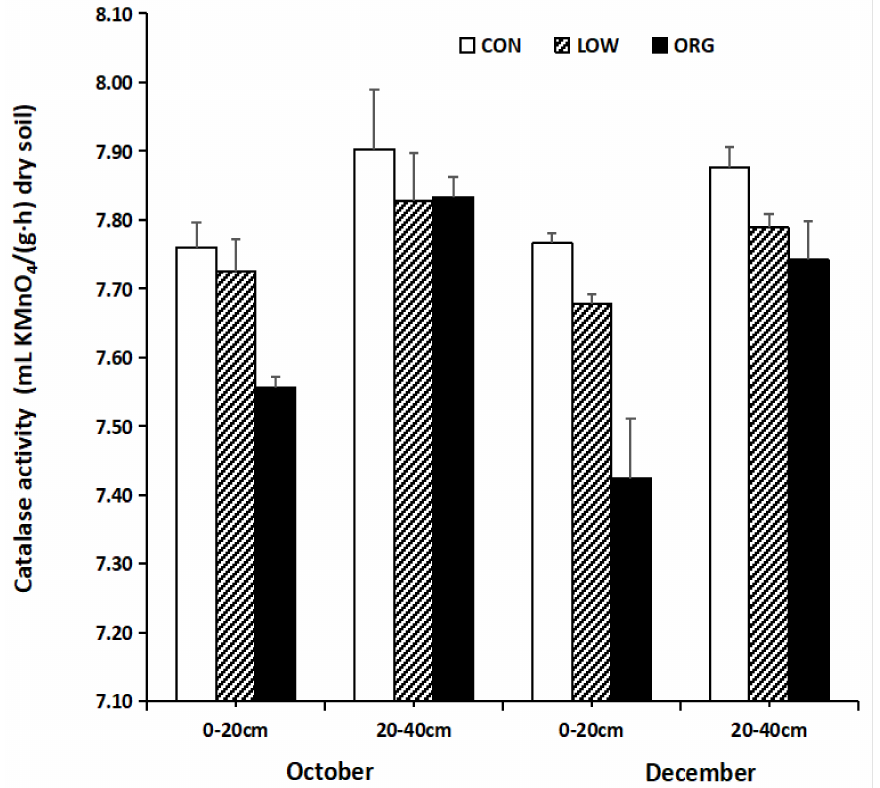
Figure 2. Effect of conventional, low-input, and organic practices on soil catalase